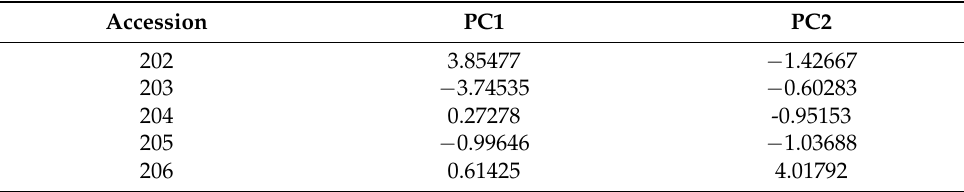
Table 7. Factor coordinates of accessions, based on